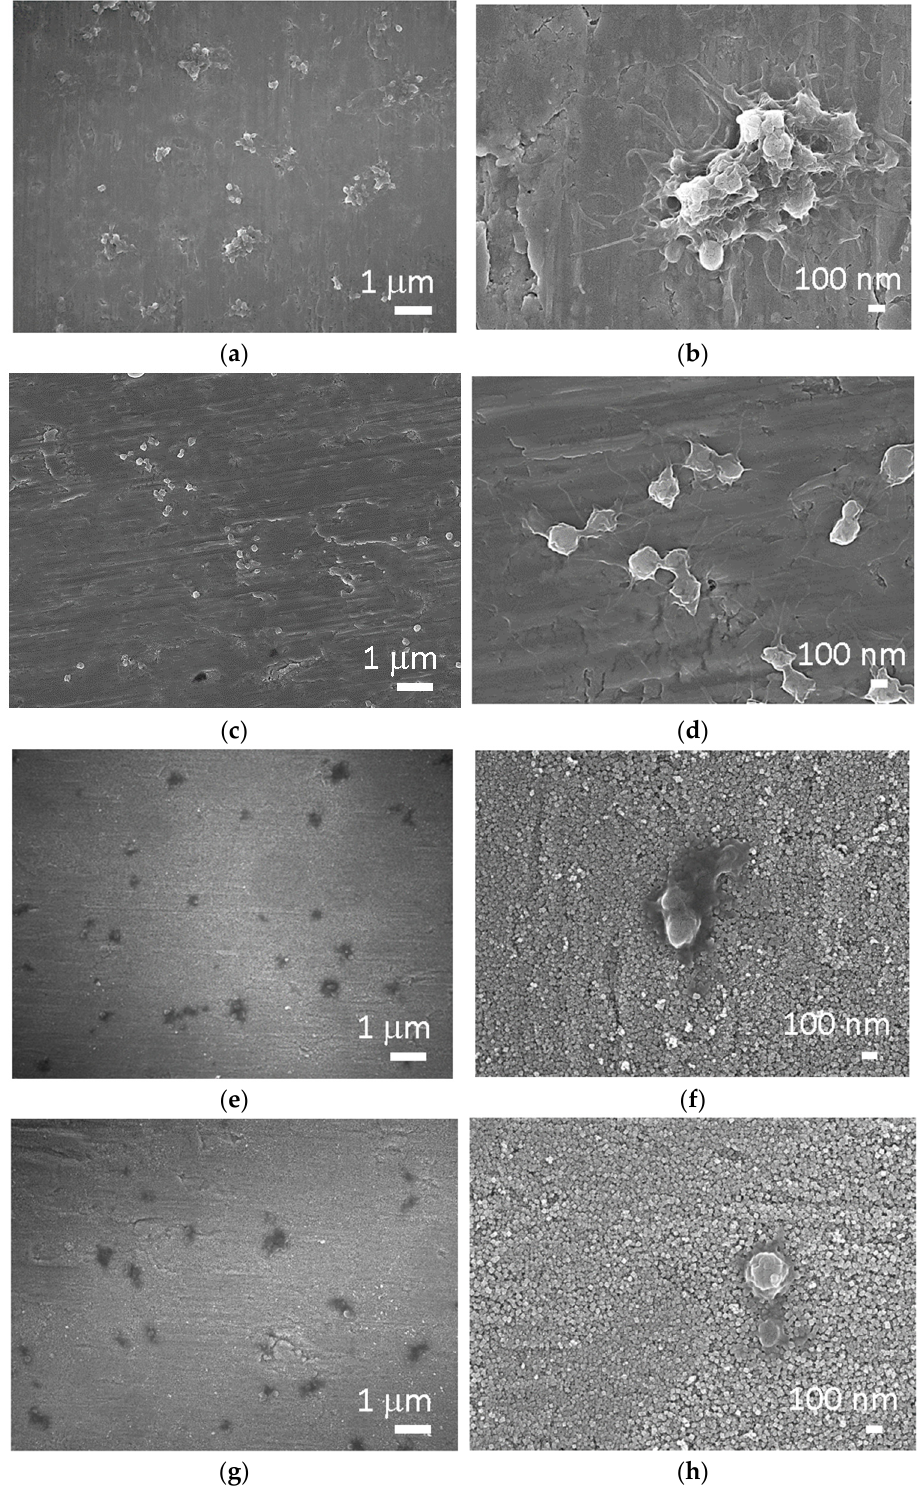
Figure 4. SEM images of ( a , b ) Ti foil, ( c , d ) Ti foil treated with plasma (Ti + P), ( e , f ) hydrothermally treated Ti foil (Ti HT) and ( g , h ) hydrothermally/plasma-treated Ti foil (Ti HT + P) after incubation with whole